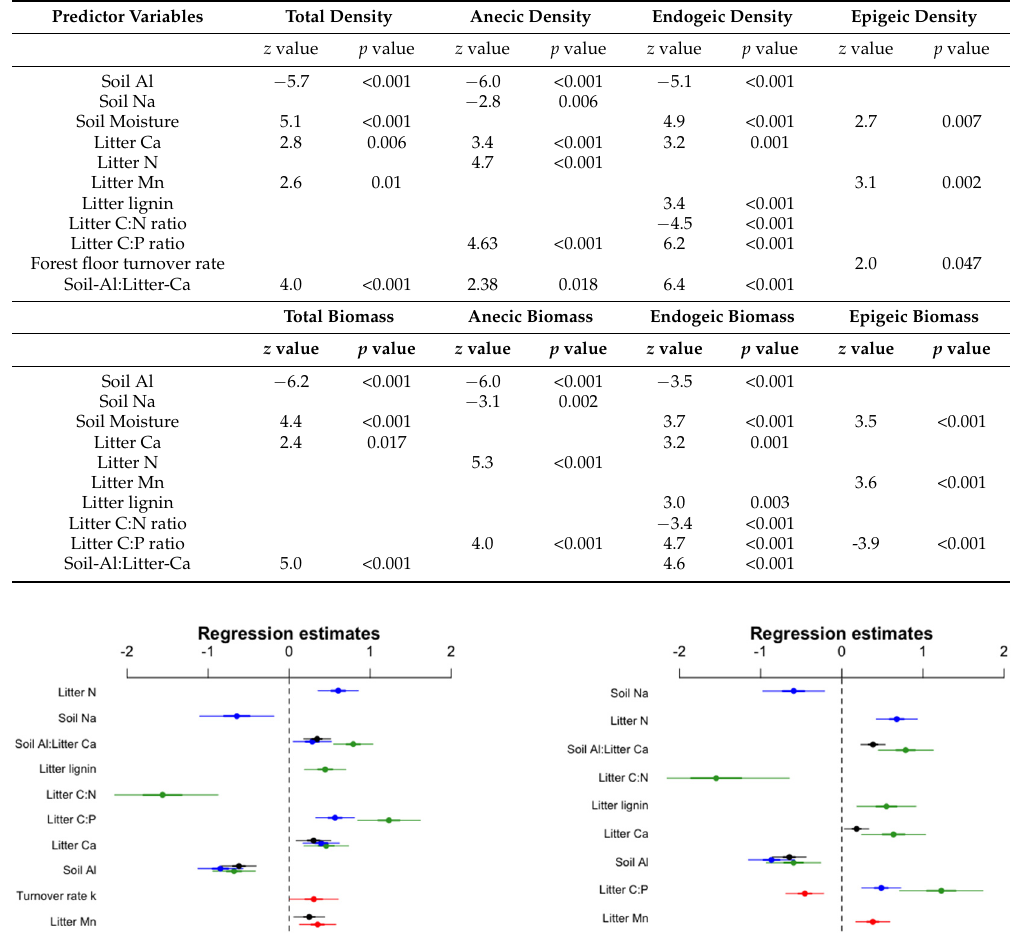
Table 5. Summary of the results identifying optimal models for total, anecic, endogeic and epigeic density and biomass. We used glmmADMB zero inflated models with Site as random effect. The foliar litter nutrient concentrations were previously published by Vesterdal et al. [35,36].